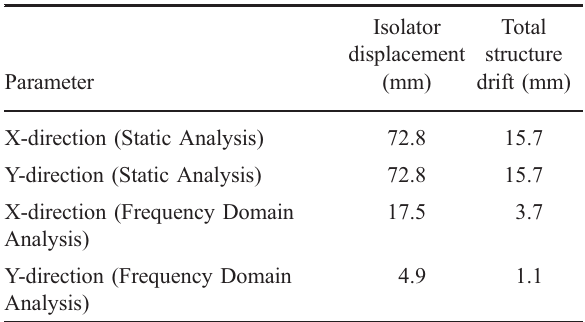
Table 6. Displacement output in dynamic analysis (isolated building)